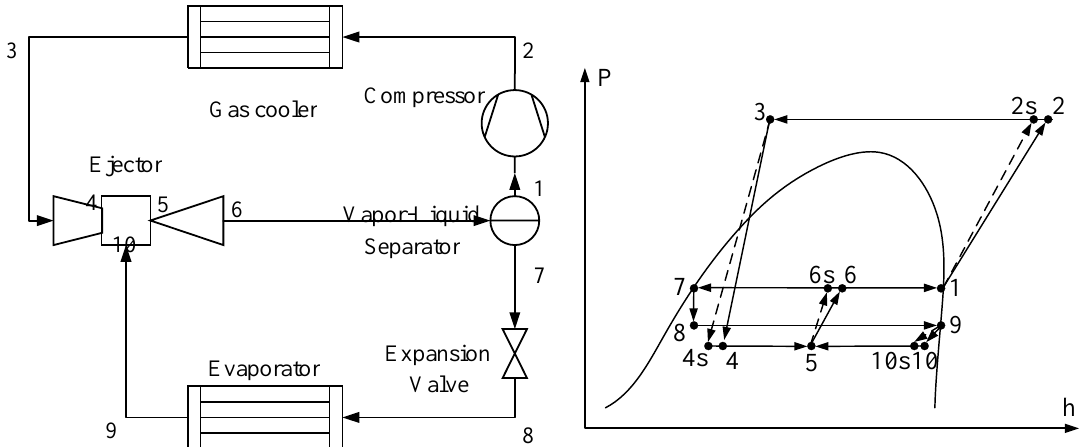
Figure 4. Schematic diagram of the transcritical CO 2 cycle with an ejector (model 4: ejector cycle).